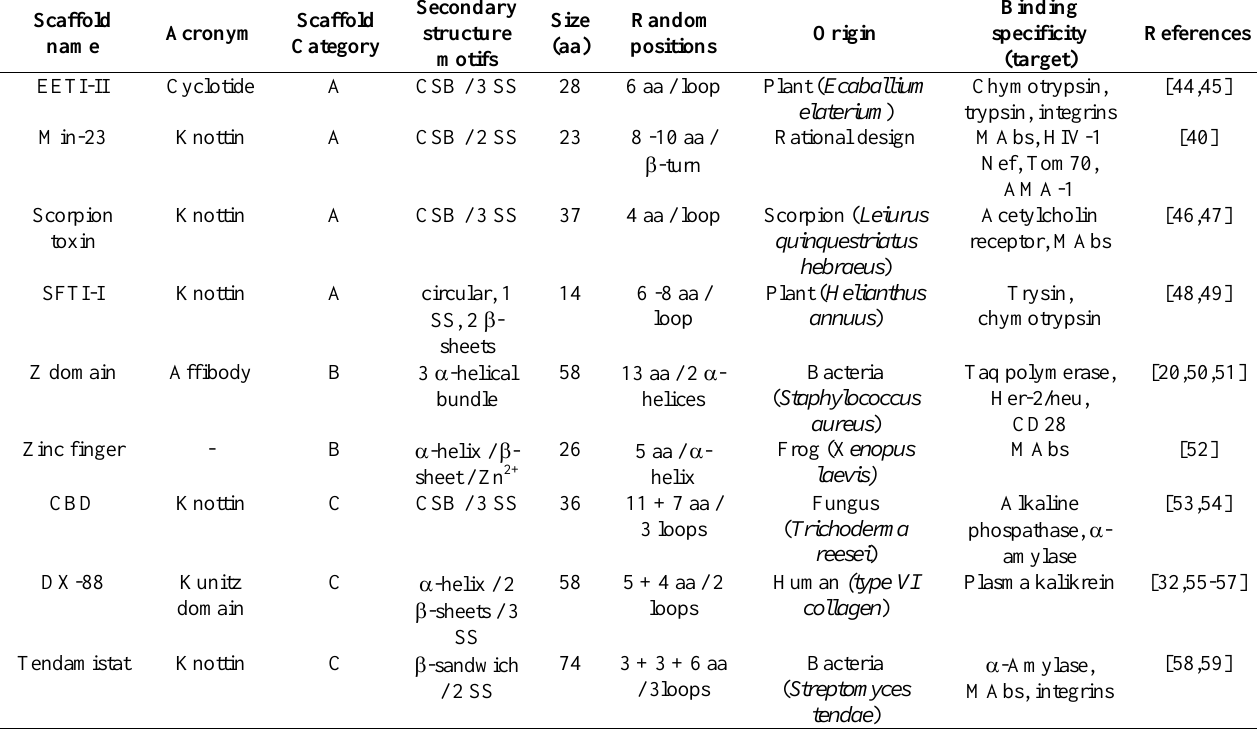
Table 1. Examples of suitable miniprotein scaffolds for phage display library construction. Scaffold categories: Scaffolds displaying a single exposed loop (A); scaffolds displaying a non-contiguous surface domain (B); scaffold displaying multiple discontinuous variable regions (C). Abbreviations: Ecballium elaterium trypsin inhibitor II (EETI-II);